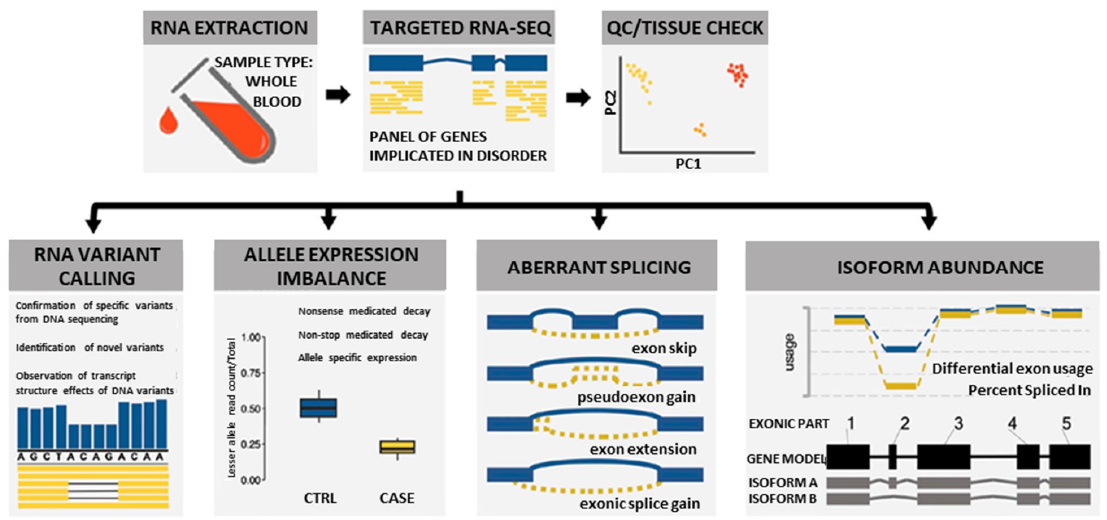
Figure 1. Overview of multi-faceted approach used to analyze RNA to aid in the diagnosis of dysferlinopathy.